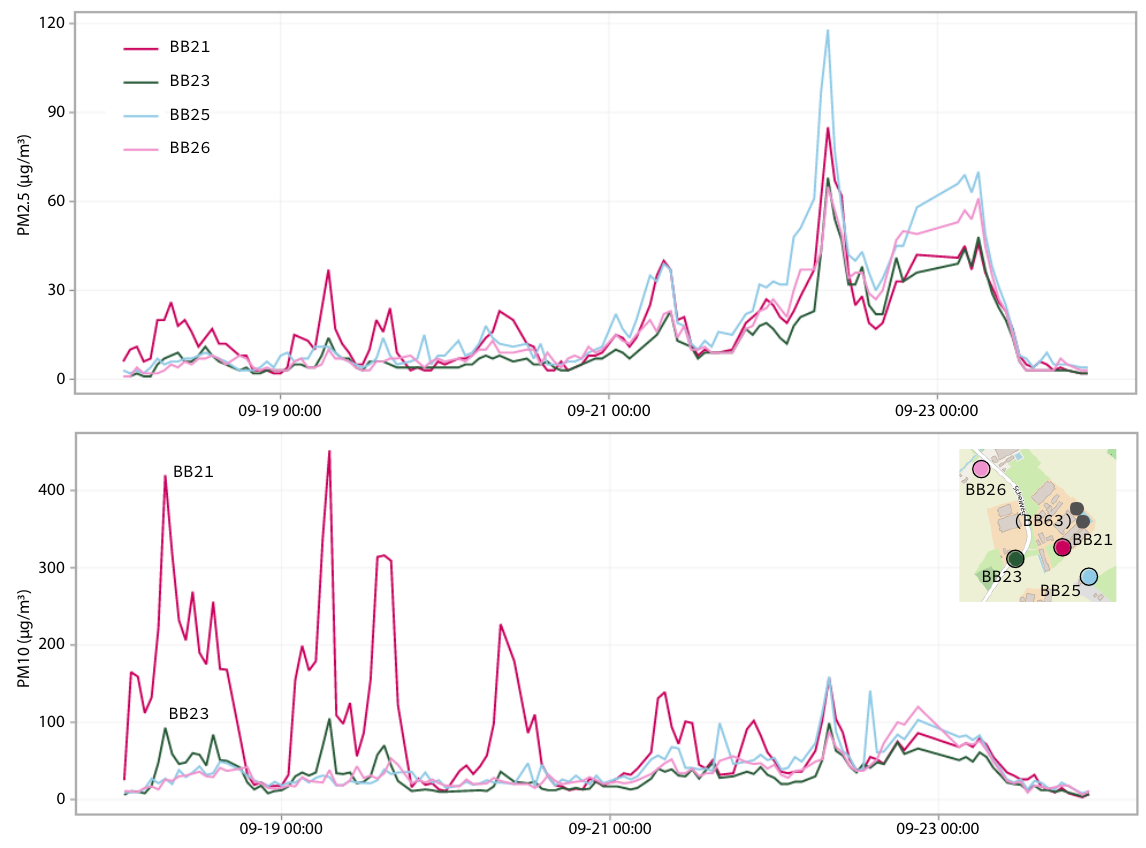
Figure 6. Time series showing PM 2.5 and PM 10 concentrations over the course of four days for four sensors in Leunen. No measurements were taken by sensor BB63 during this period.